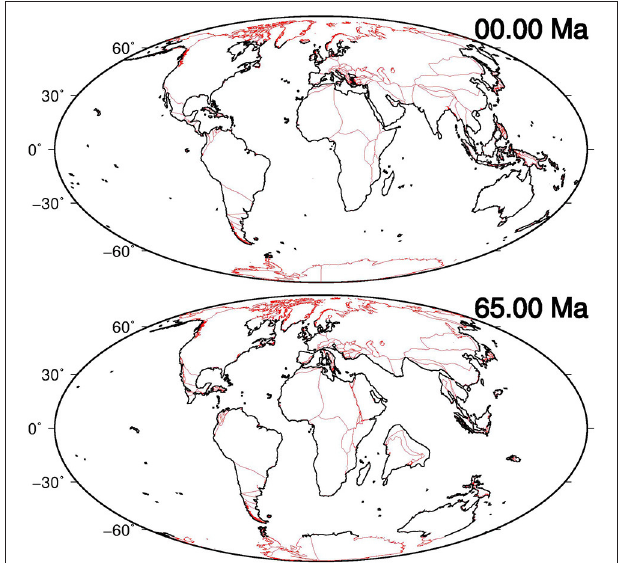
FIGURE 2 | Present-day (0 Ma) and reconstructed (65 Ma) positions of continents using models provided by Seton et al. (2012) (red polygons). Black lines represent digitalized, and simplified data, estimated in a range of latitude [ − 65 ◦ N, 65 ◦ N] in which seagrasses are presumed to have existed, and utilized to compute global coastal lengths at several key-time